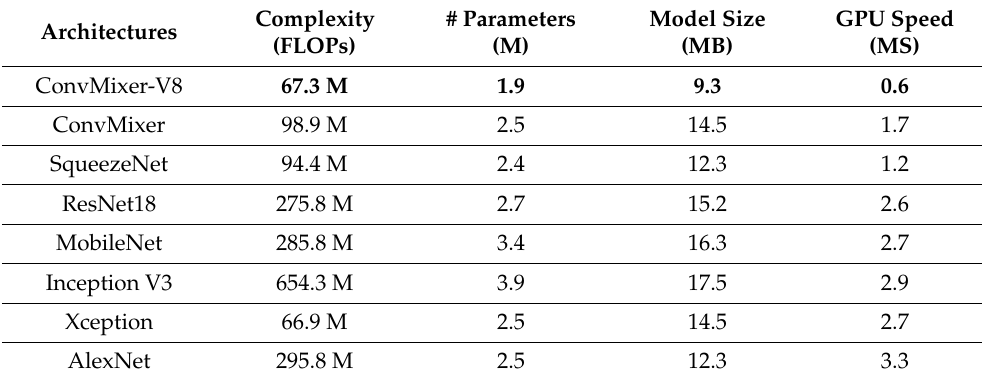
Table 7. Computational performance of the different DL